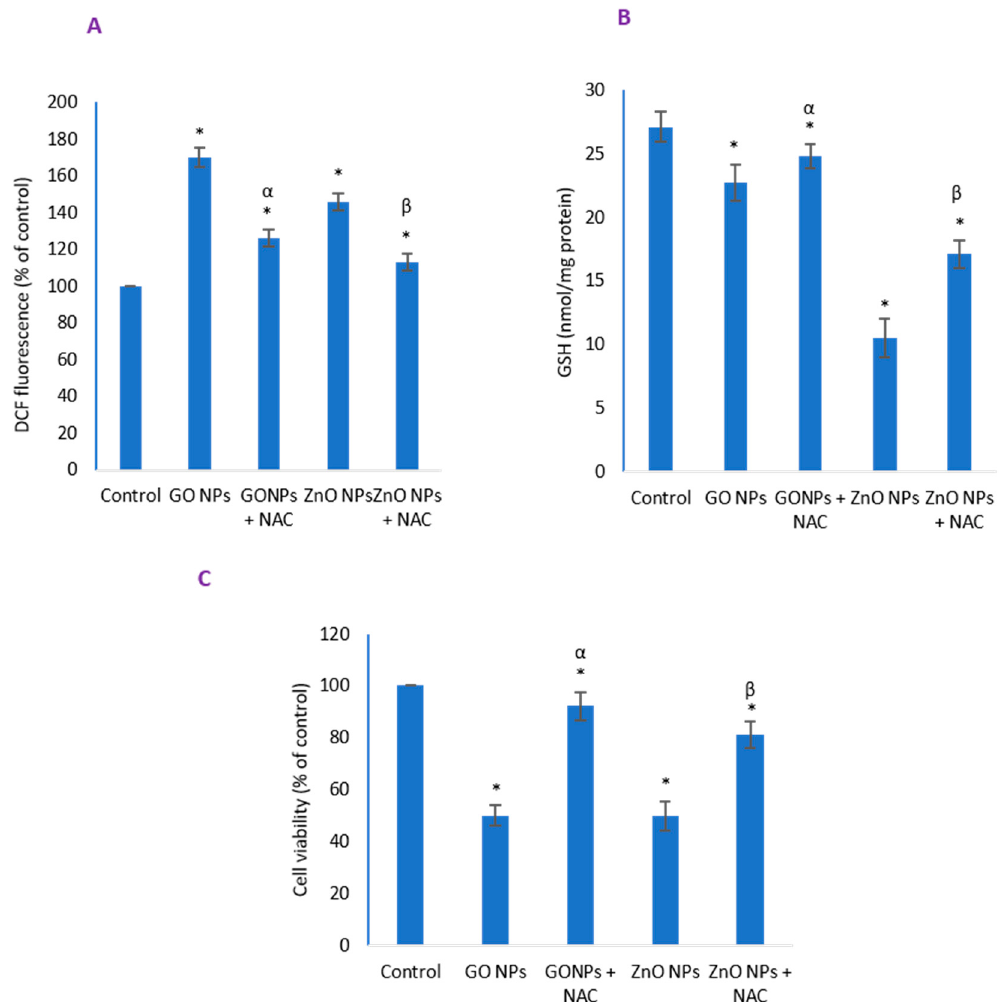
Figure 7. Inhibitory effect of N-acetylcysteine (NAC) cotreatment on ( A ) ROS-induction, ( B ) GSH-depletion—and consequently, ( C ) cytotoxicity that would otherwise be induced by NPs alone. * Statistically significant difference than the controls ( p < 0.05). α and β denote significant preventive potential of NAC on ROS generation, GSH decline and cytotoxicity due to GO NPs and ZnO NPs, respectively ( p < 0.05).